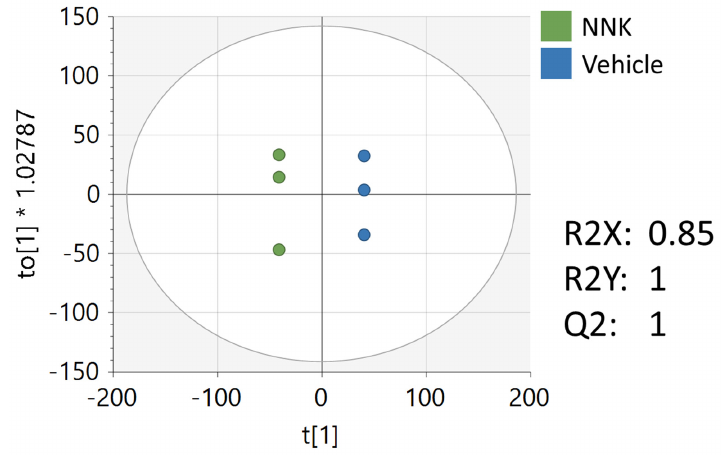
Figure 6. OPLS-DA of the metabolomics data from NNK and vehicle-treated CAL27 cells. Unit variance scaling was used for all peaks. Table 7. Significantly perturbed metabolic pathways that differentiated NNK and vehicle-treated CAL27 cells.